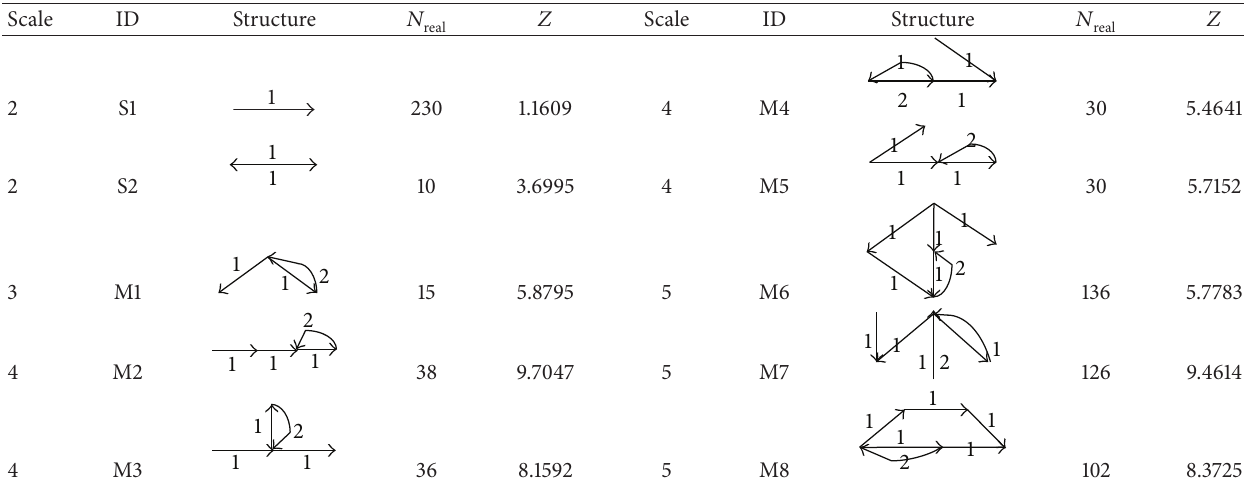
Table 2: The sample of frequent subgraph and network motifs.